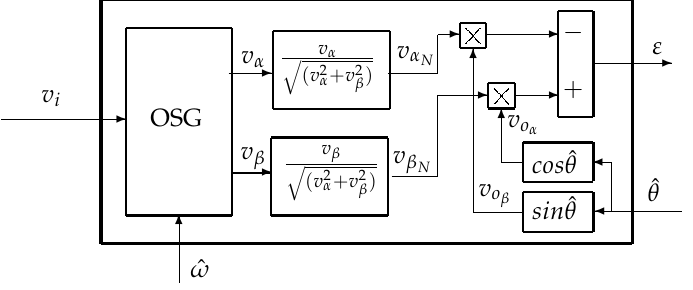
Figure 4. Normalization of input